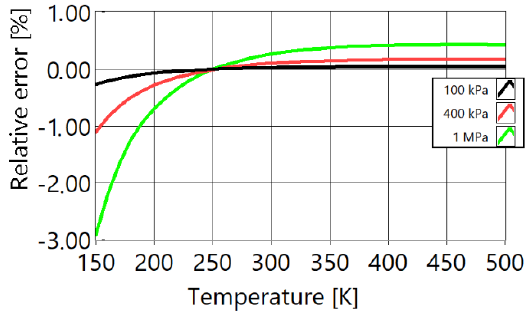
Figure 2. Comparison of ideal value of free field speed of sound with the full model that includes the effects of real gases. With black is marked isobar of 100 kPa, with red is marked isobar of 400 kPa and with green is marked isobar of 1 MPa of pressure inside of PAT waveguides.